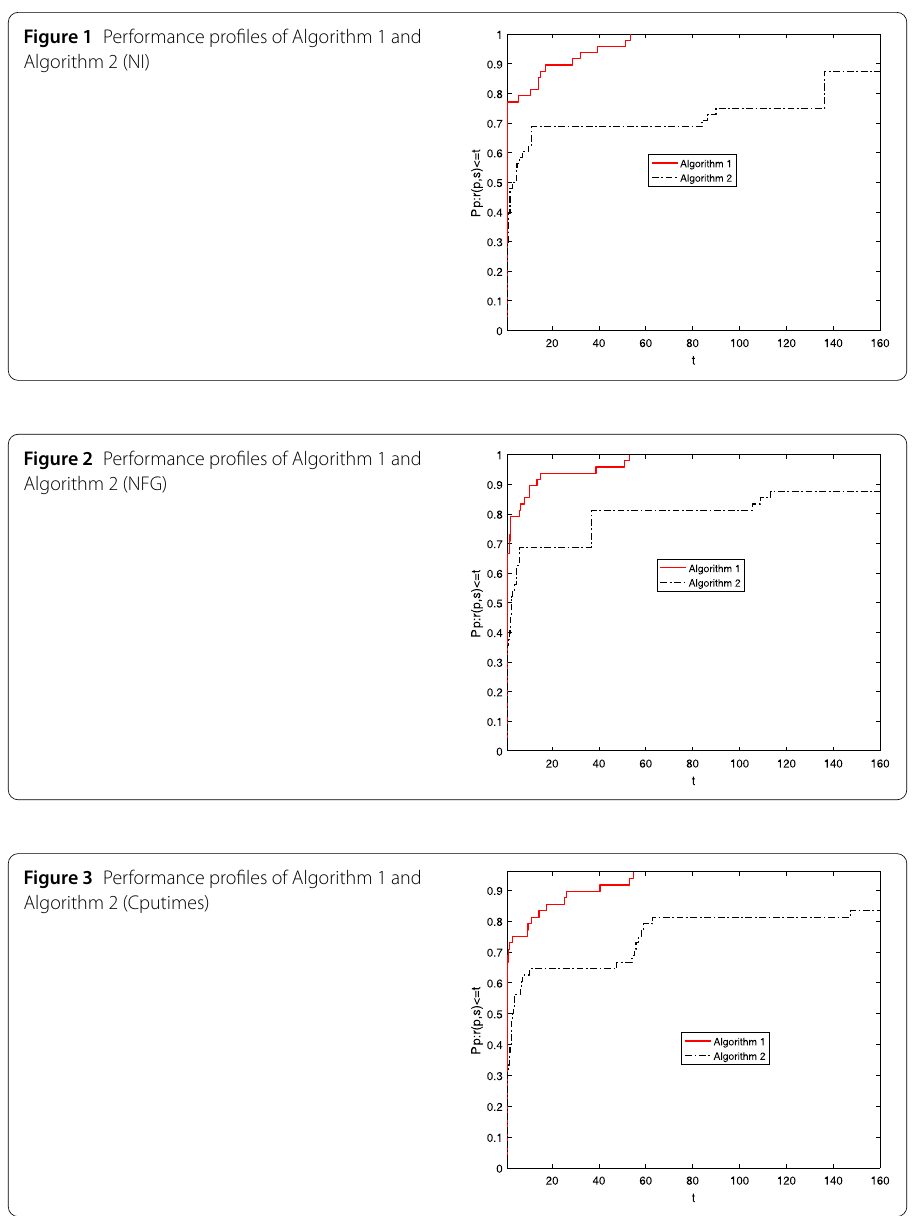
Figure 1 Performance profiles of Algorithm 1 and Algorithm 2 (NI)